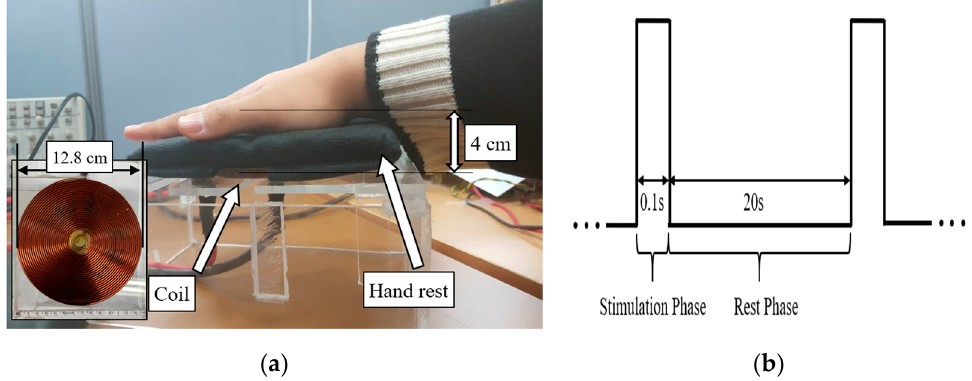
Figure 3. Experimental protocol: ( a ) Flat spiral coil, hand rest, and hand position for tactile stimulation. ( b ) Block design for human experiments.